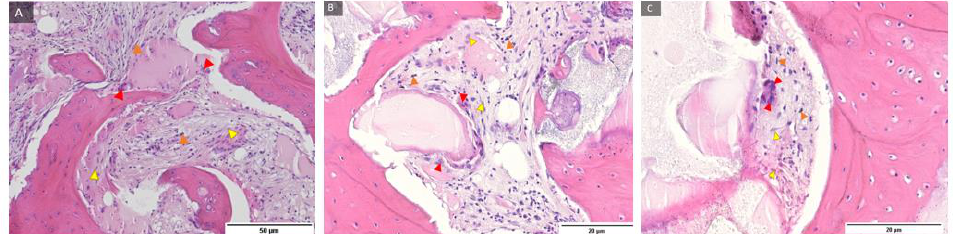
Figure 4. Examples of preparations of the test group ( A – C ) with labelled fibroblasts (yellow filled triangle), fibrocytes (orange filled triangle), and cells of the monocyte–macrophage system (red filled triangle). Magnification: 100, 200, 400 ×